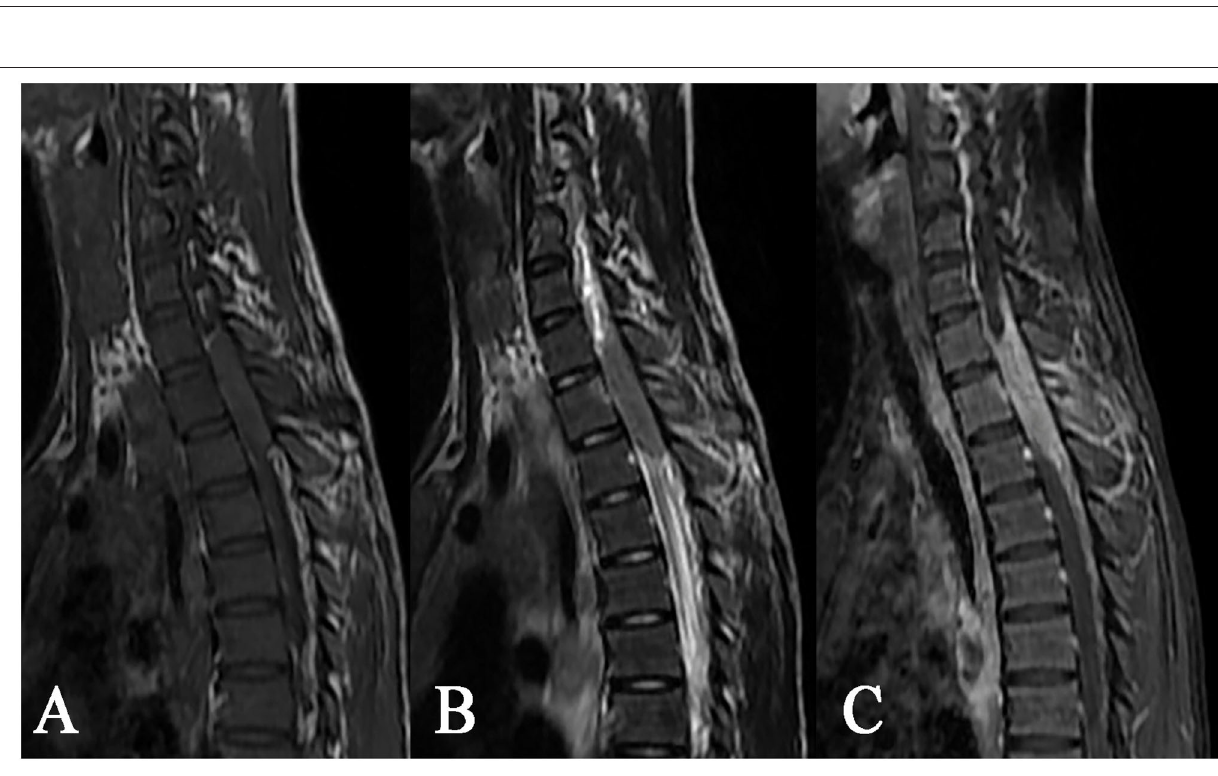
FIGURE 4 | Epidural tuberculoma at the cervicothoracic junction. A lesion having a longitudinal fusiform shape: (A) isointense on T1WI, (B) isointense on T2WI, and (C) distinct homogeneous enhancement after contrast enhancement, showing extension to adjacent spinal meninges and compression of adjacent spinal cord accompanied by tuberculosis of the adjacent